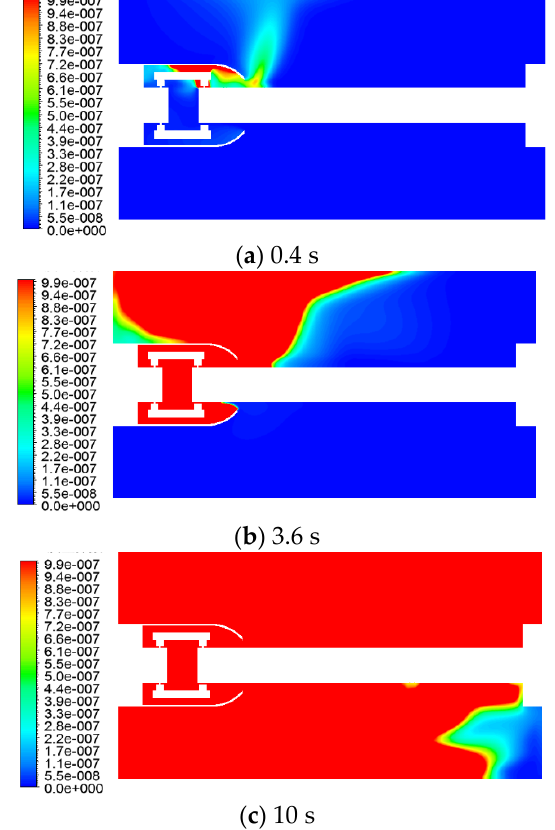
Figure 11. H 2 S mass fraction as a function of time.